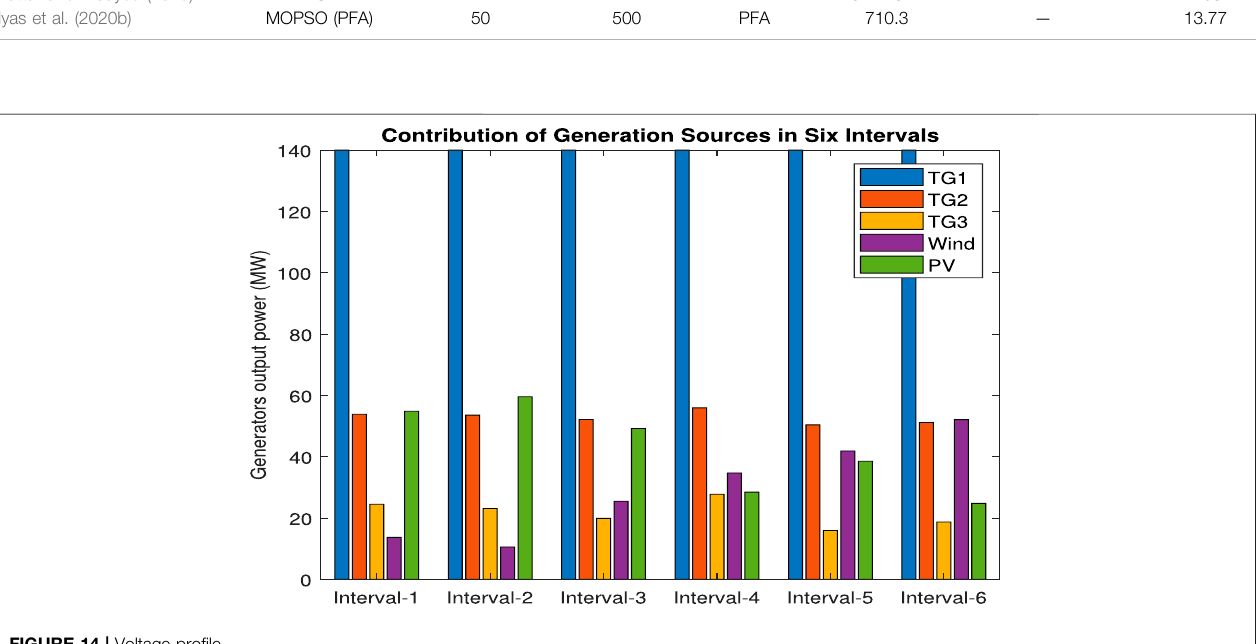
FIGURE 14 | Voltage pro fi